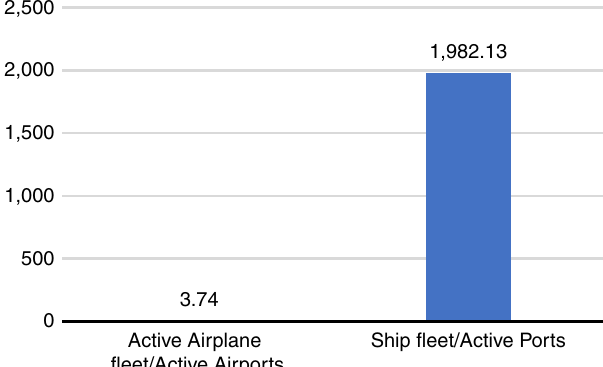
Figure 7. The ratio of ship/ airplane fleet to air/ ports in Iran